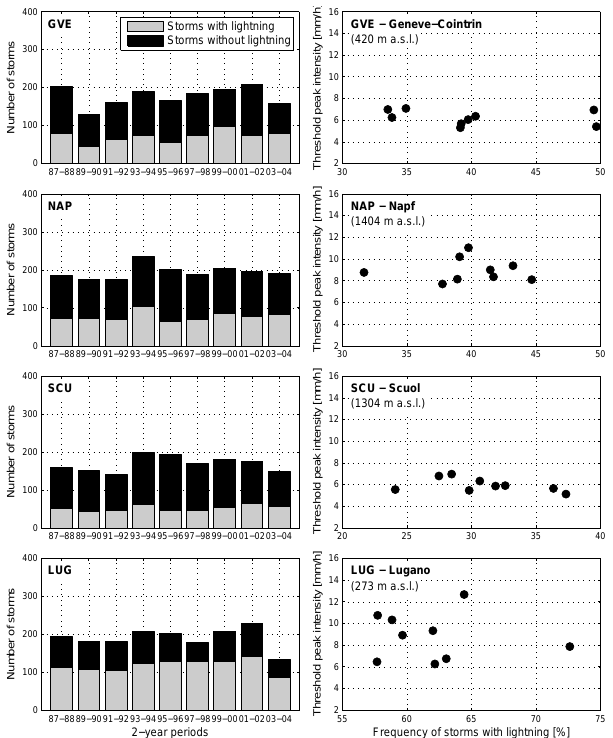
Fig. 8. Number of storms with and without lightning on a bi-annual basis (left column) and the relationship between threshold peak in- tensity I ∗ and the frequency of storms with lightning on a bi-annual basis (right column) at the studied stations. Note the different scale of x axes for the stations.